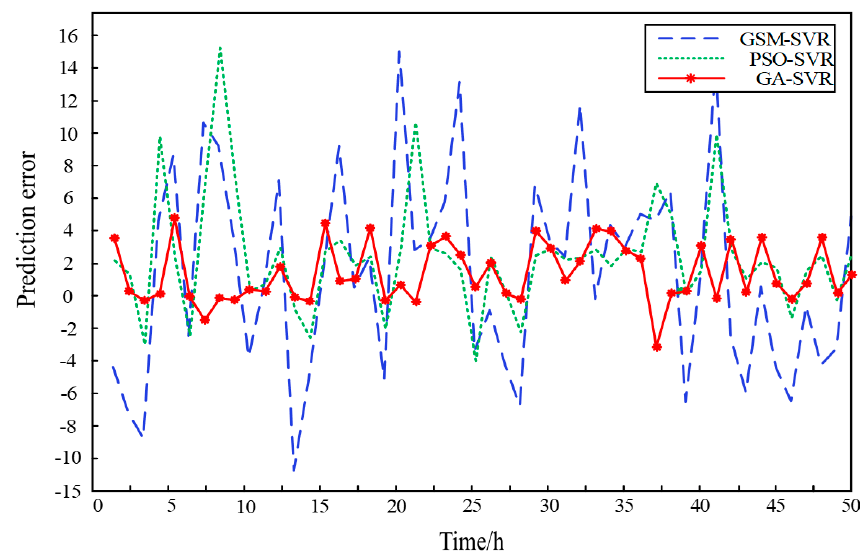
Figure 6. Comparison of prediction errors of each method. Table 1. Comparison of evaluation index and training